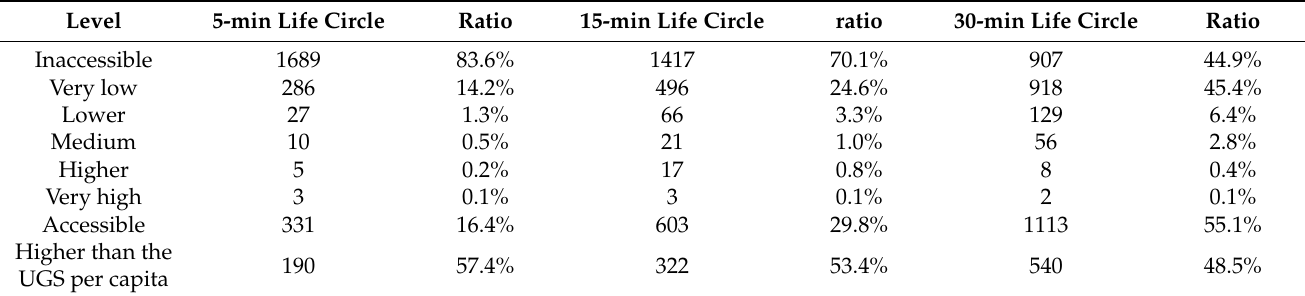
Table 4. Accessibility grading statistics of residential areas under different traveling scopes.